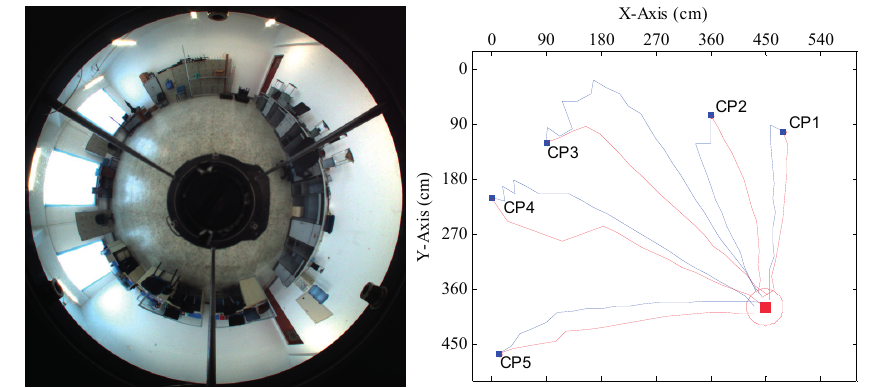
Figure 14. Robot homing Trial 3.